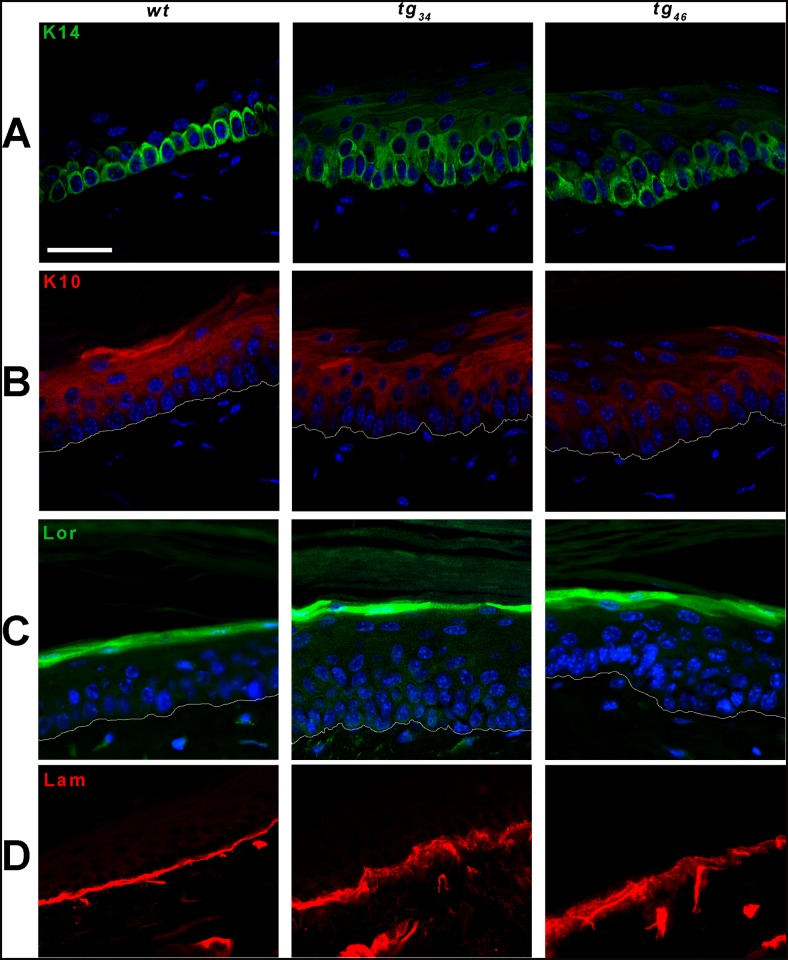
Defects in epidermal markers in tg
34 and tg
46 epidermis.Representative immunofluorescent stainings of keratin14 (K14), specific for basal cells (panel A), keratin10 (K10), specific for suprabasal cells (panel B), and loricrin, specific for terminally differentiated cells (panel C), were performed on paraffin sections of tail skin and analysed by confocal microscopy. Abnormal K14 staining is observed in cells above the basal layer, while K10 staining appears less intense in suprabasal cells of transgenic samples compared to wt. Three to five mice were used for each genotype. White lines delineate the dermo-epidermal junction. Scale bar: 20μm.